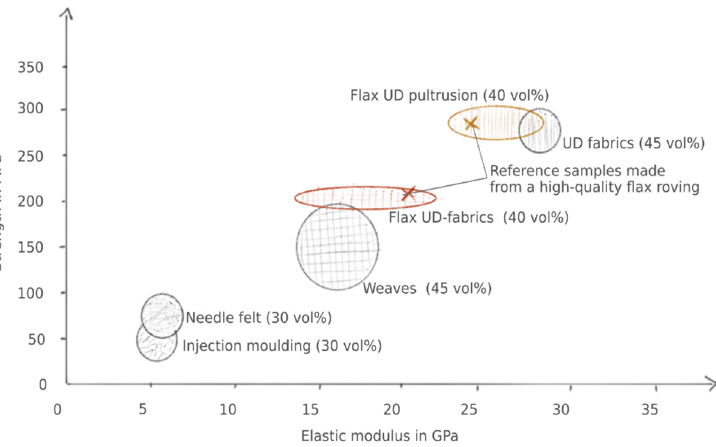
Figure 17. Classification of the mechanical characteristics of the produced composites compared to literature values and the reference composites.